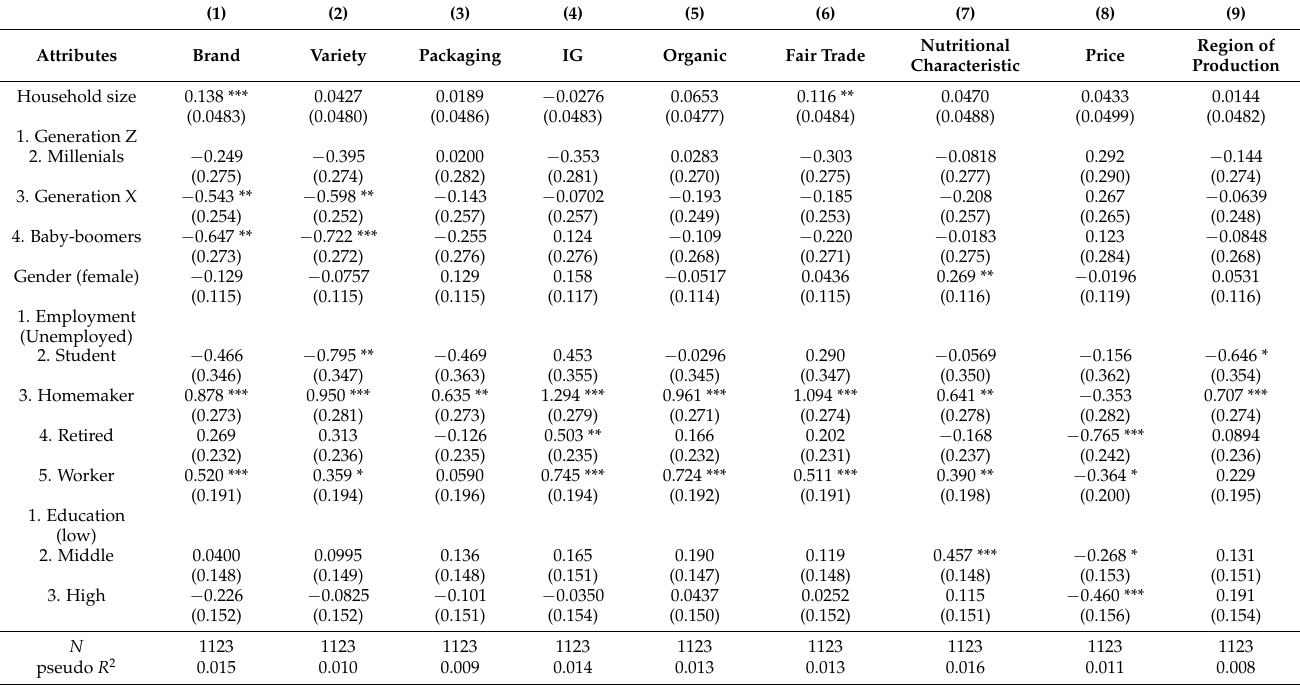
Table 4. Ordered logit model estimates for the nine date attributes